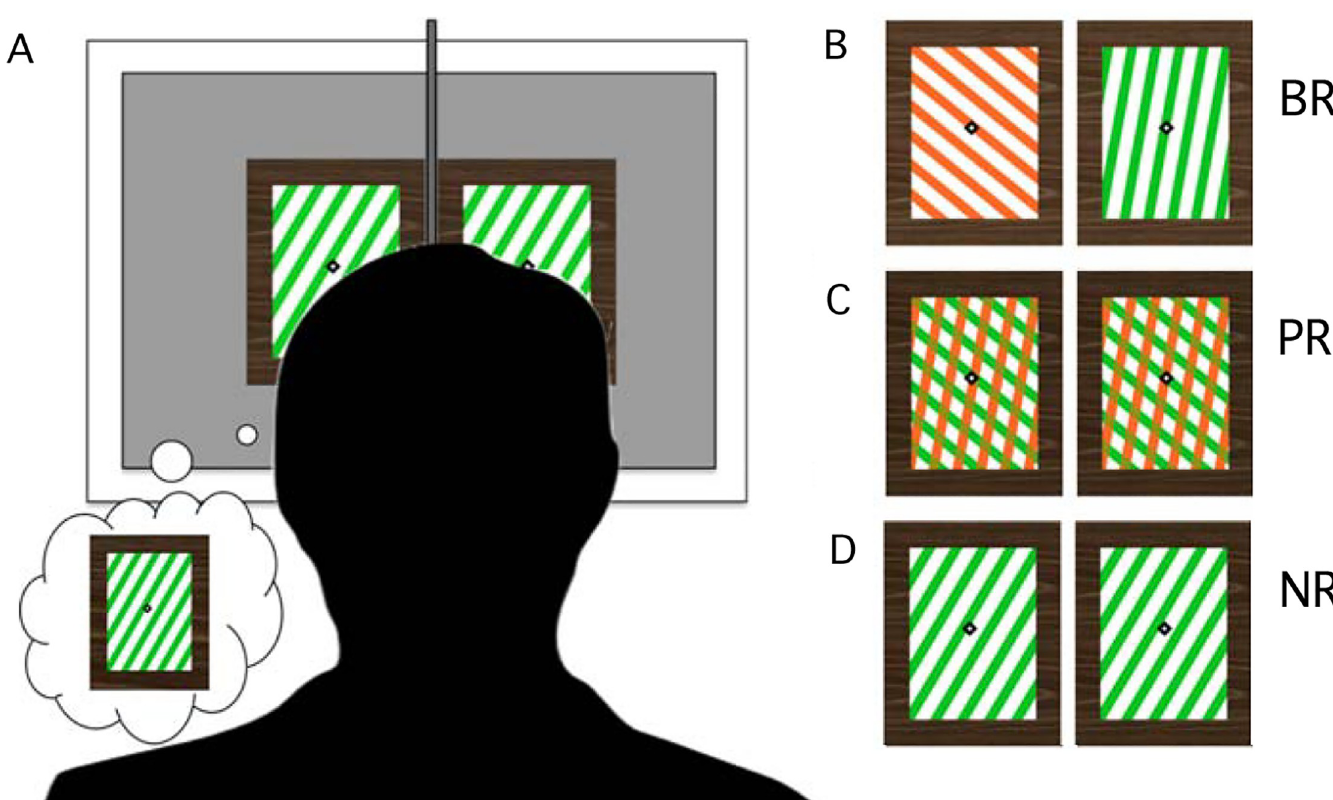
Fig 1. Dichoptic viewing setup and three task conditions. A. Subjects wore prism glasses that allowed fusion of separate stimuli viewed by the left or right eye. An opaque divider was placed between the subject’s face and the screen to block any additional images and scattered light. Three tasks with similar but different stimuli were used. In all cases, the stimulus shown to the left eye flickered at 5 Hz, and to the right eye at 7.5 Hz. B. Binocular rivalry (BR) used incompatible images in each eye that different in color and orientation. Subjects indicated their perceptual alternations with button press. C. Pattern rivalry control task (PR) used identical stimuli in each eye. However, the two grating components (with different color and orientation) alternated in visibility/salience, and subjects reported their alternations with button press. Note here that eyes not grating components were tagged. D. No rivalry (NR) was a type of replay control task with identical stimuli in each eye that changed physically every 1–3 seconds to mimic natural